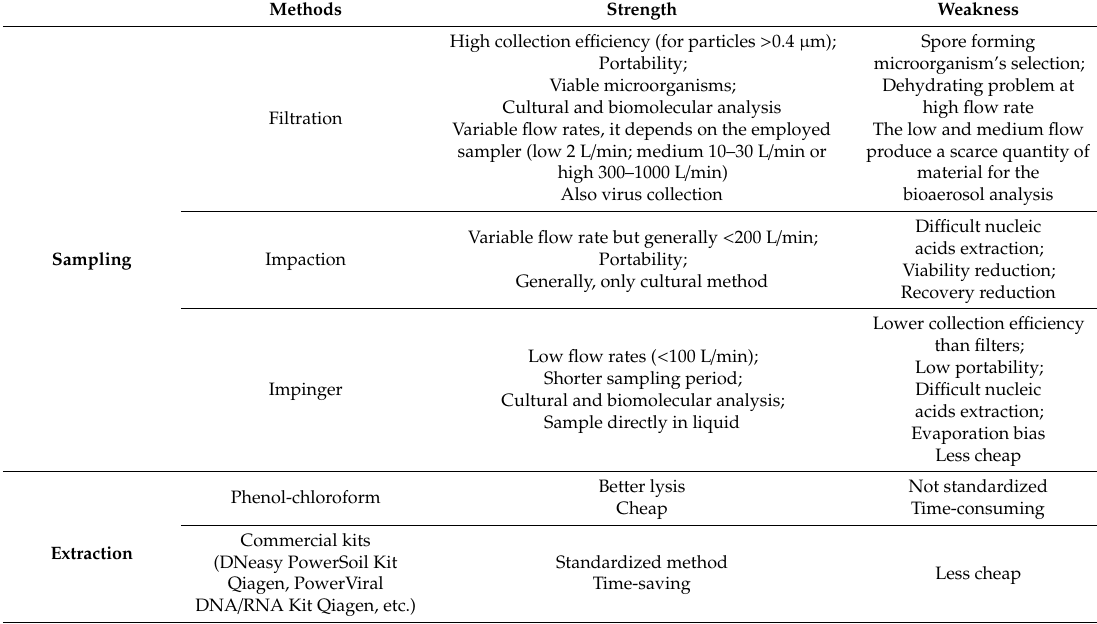
Table 3. Sampling, extraction and analysis methods summary